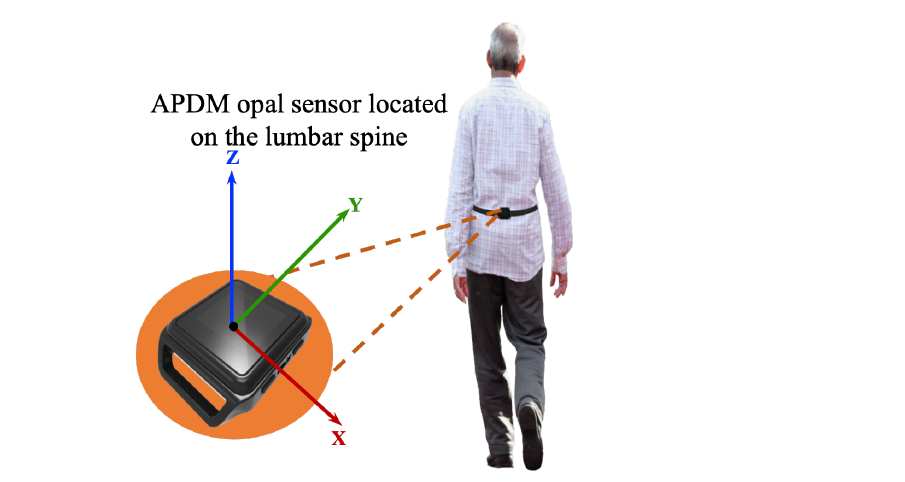
Figure 8. Illustration of the IMU setup. APDM opal sensors were positioned on the subjects’ lower backs over the clothing using elastic